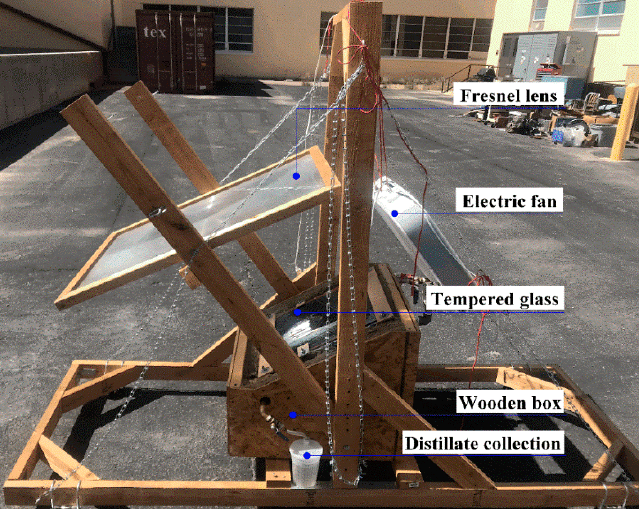
Figure 2. Fresnel lens enhanced solar still.